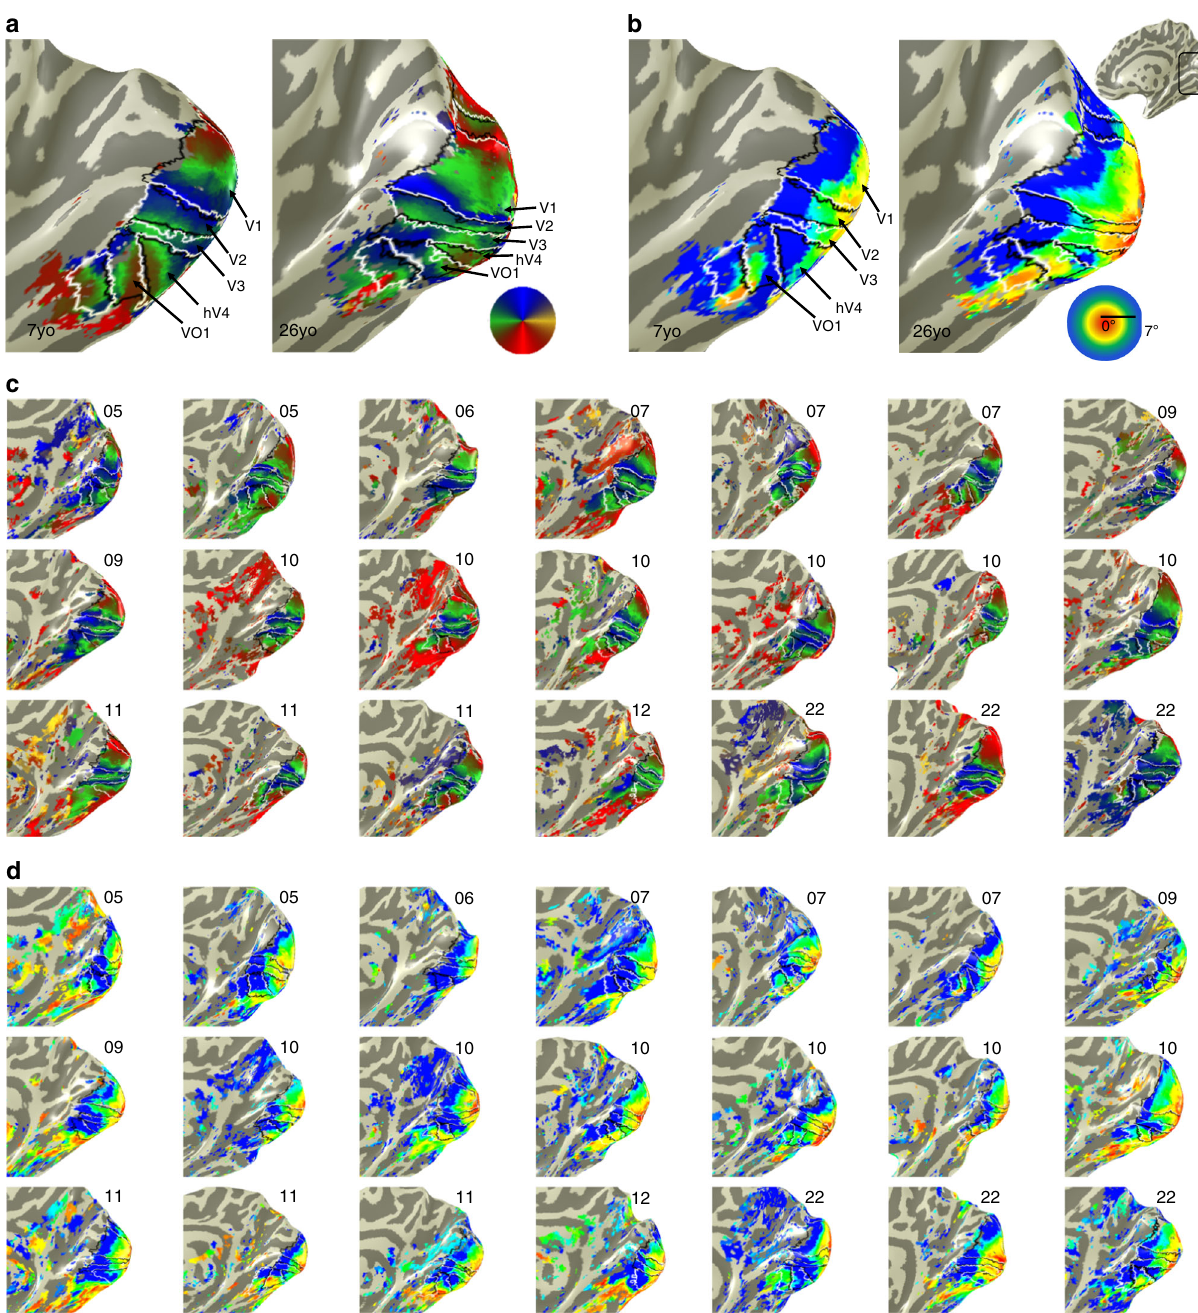
Fig. 1 Early visual areas show no qualitative development. a Polar angle maps from an example 7-year-old and 26-year-old. Color wheel: polar angle. Data are shown within an anatomical mask encompassing the central 7°. b Eccentricity maps in the same participants. Color wheel: eccentricity. Inset brain shows zoomed region in black outline. c Polar angle maps and d eccentricity maps in the right hemisphere of all child participants and three example adults. Numbers indicate the age of the participant. Maps are of the central 7° and are thresholded at 5% variance explained, voxel level. Lines: boundaries of visual fi eld maps. Polar angle and eccentricity maps of all participants and both hemispheres are shown in Supplementary Figures 3 –